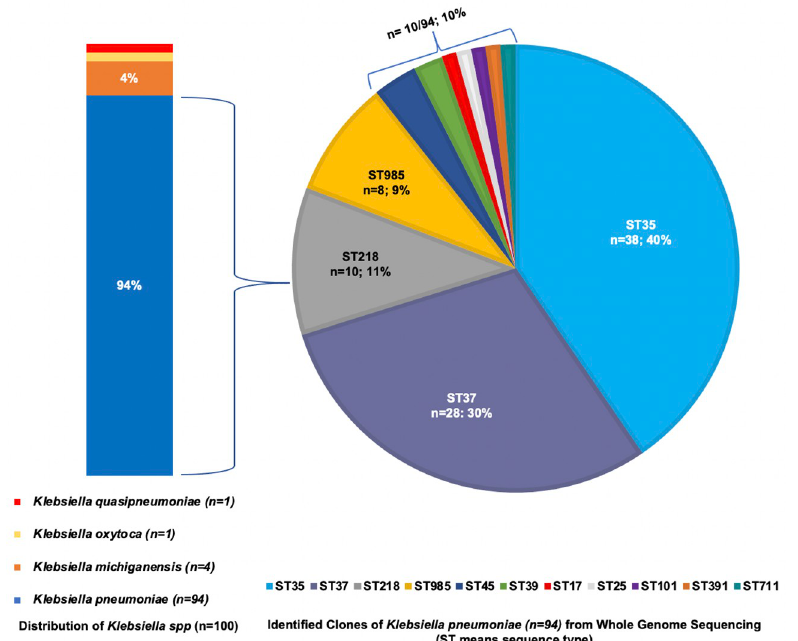
Fig 4. Distribution of Klebsiella spp (n = 100) and the clonal strains of Klebsiella pneumoniae (n = 94). Klebsiella pneumoniae accounted for 94 out of the 100 Klebsiella spp identified. There were 11 sequence types (ST) and capsular- antigen serotypes (KL) of Klebsiella pneumoniae identified; ST35/KL108 (n = 38) and ST37/KL15 (n = 28) accounted for 70% (n = 66/94) of all infections attributed to Klebsiella pneumoniae